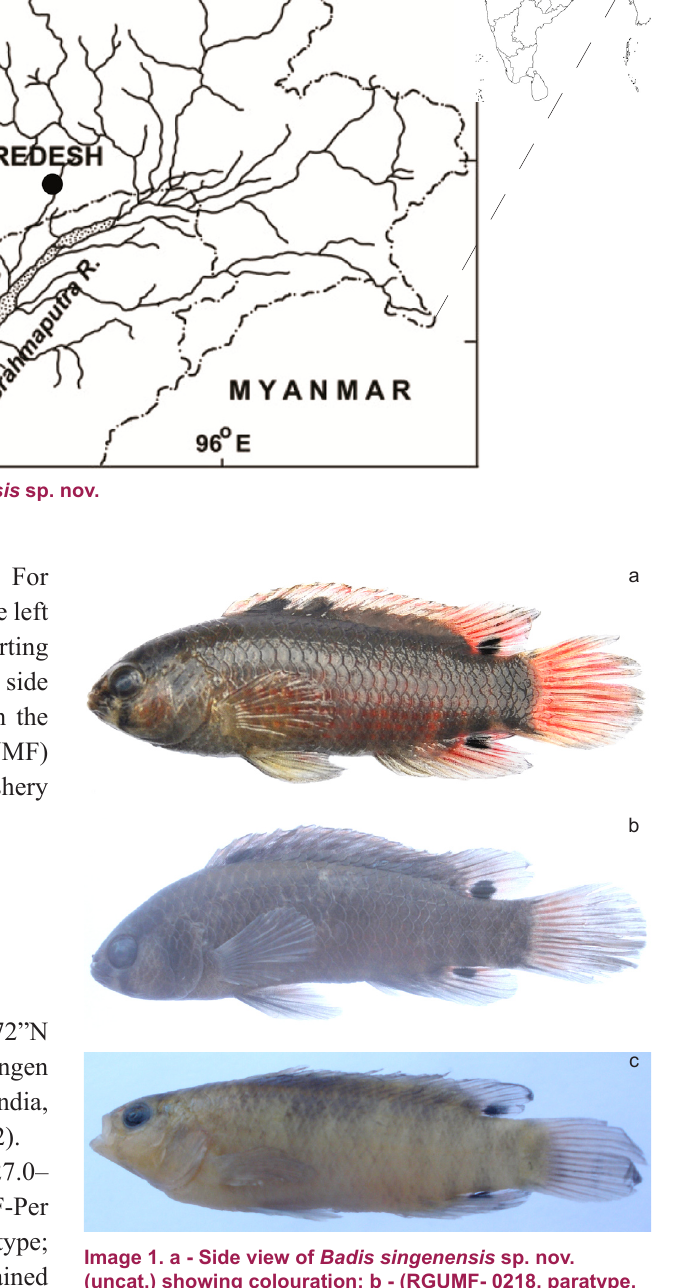
Image 1. a - Side view of Badis singenensis sp. nov. (uncat.) showing colouration; b - (RGUMF- 0218, paratype, female); c - (RGUMF- 0219, paratype, male)